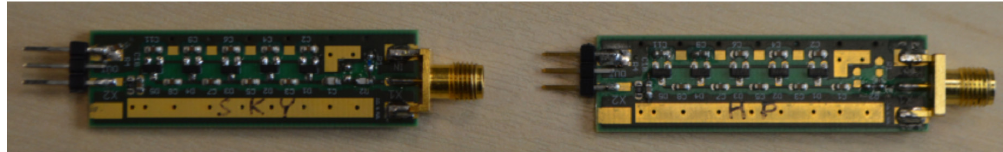
Figure 2. Photograph of the two variants of the self ‐ developed RF ‐ EH circuit based on HP and SKYWORK manufactured diodes.